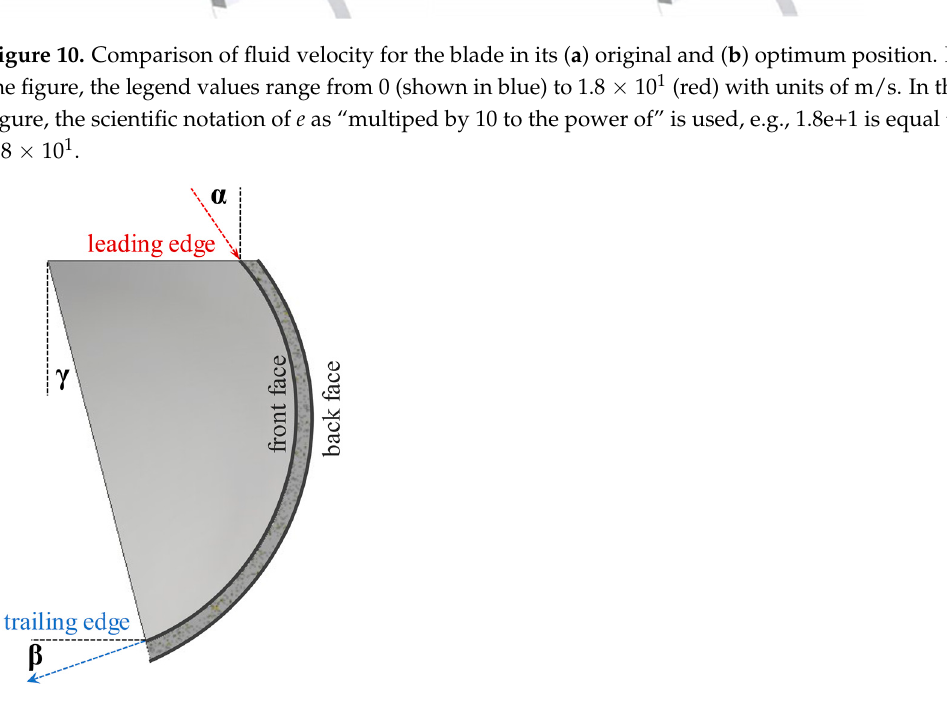
Figure 11. Section view of the blade in the central plane which identifies α , entry angle; β , exit angle; and γ , blade cut back angle.